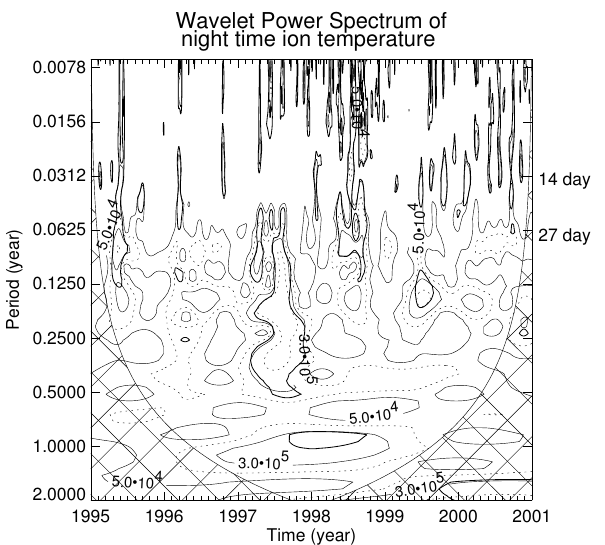
Fig. 14. Wavelet spectra of solar radio flux during 1995–2000. Other details are same as in Fig.